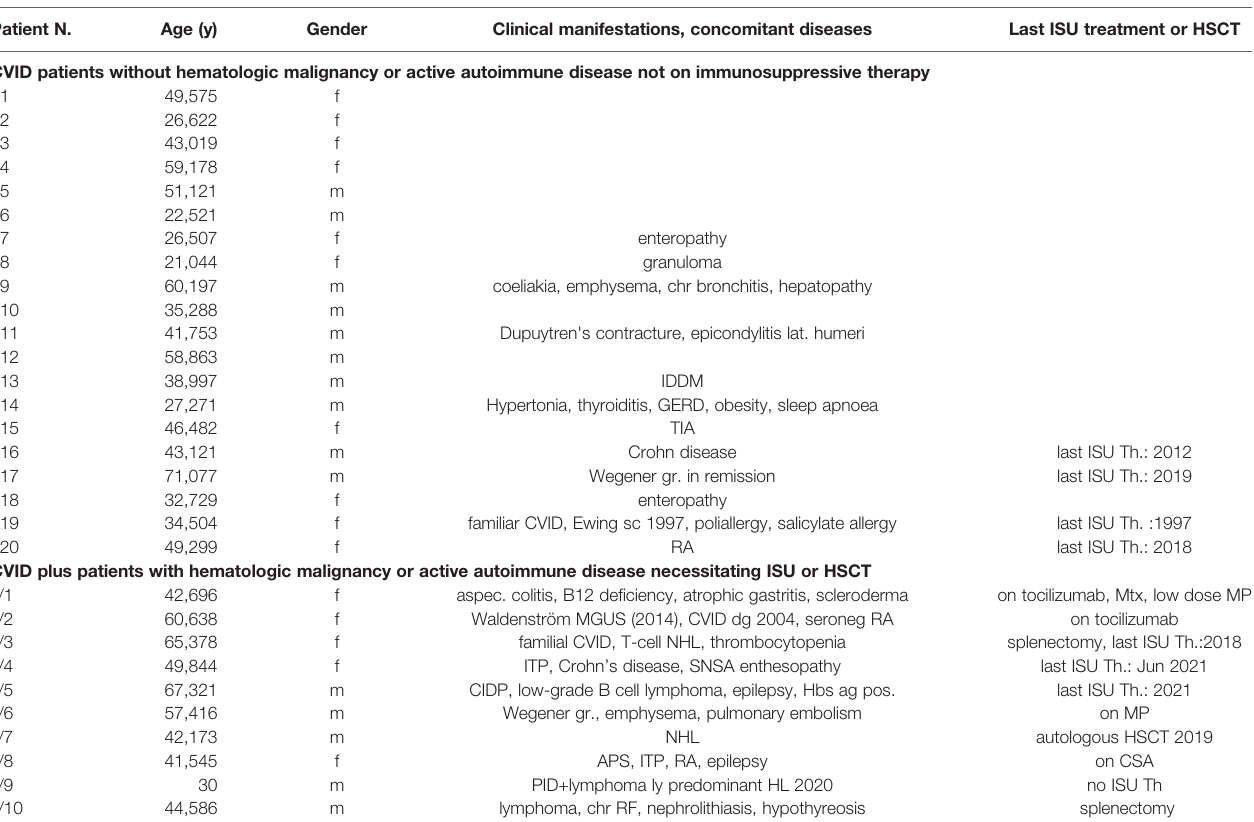
TABLE 1 | CVID patient ’ s characteristics. Patient